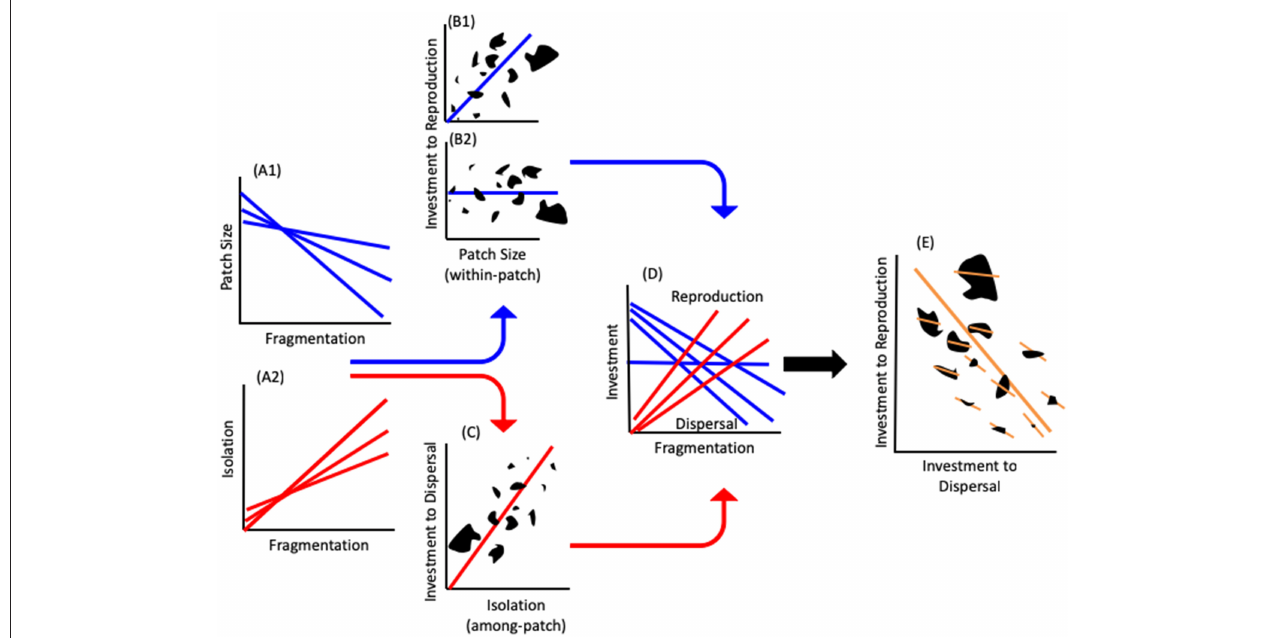
FIGURE 1 | The landscape physiology framework. The effects of fragmentation on patch size (A1) and isolation (A2) . The effects of patch size on investment to reproduction. Individuals in larger patches will invest more into reproduction (B1) or, if the landscape is exactly at carrying capacity equilibrium (B2) investment into reproduction will not change with patch size. (C) The effect of among-patch isolation on resource allocation to dispersal with higher investment to dispersal increasing with the degree of isolation. (D) Resource investment to reproduction and dispersal along a fragmentation gradient. (E) Resource allocation tradeoff at the physiological level (short, within patch, lines) create the landscape-level tradeoff (long line). Note that the within-patch slopes are shallower in larger patches. The multiple lines in (A,D) indicate that the specific slope and intercept of the relationships will vary with different combinations of patches (B,C,E) . The black shapes in (B,C,E) represent patches of different shapes and